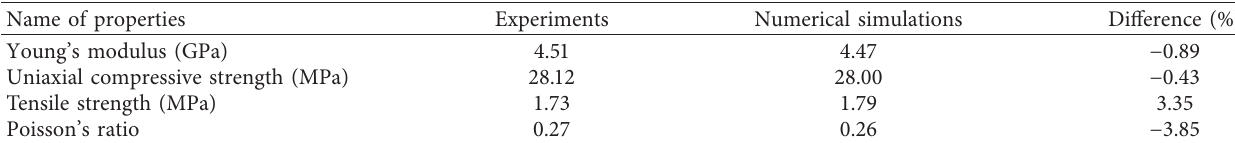
Table 7: Difference of calibrated parameters with obtained parameters from